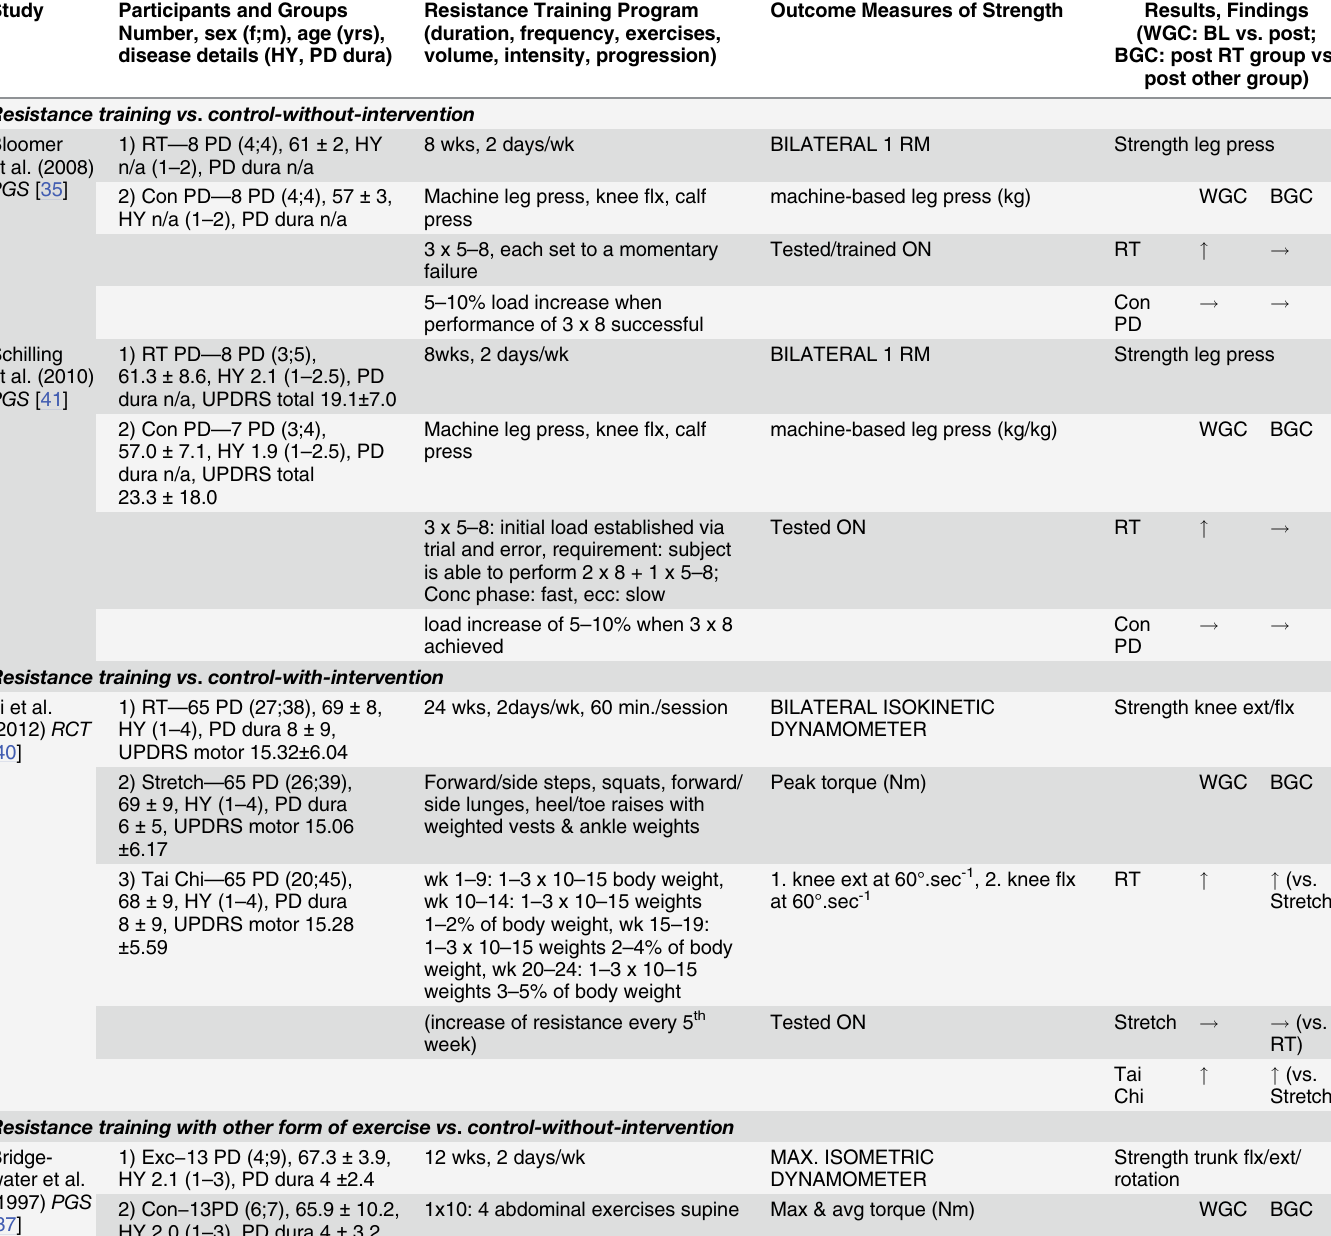
Table 1. Study Characteristics.